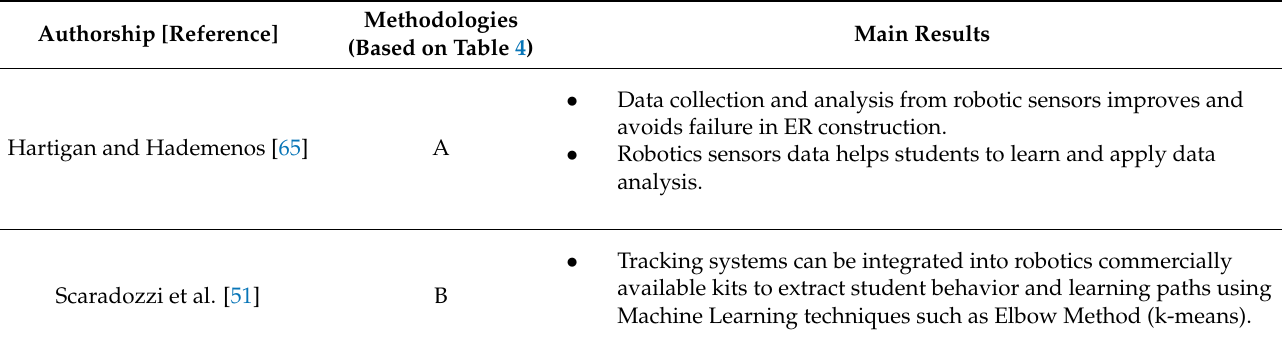
Table 7. Summary of analytical methods (based on the classification in Table 4) and main results of the papers